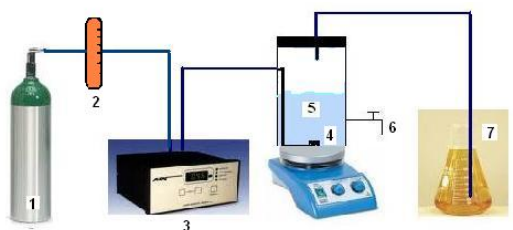
Figure 1. Schematic diagram of catalytic oxidation system. (1) Pure oxygen, (2) Flow meter, (3) Ozone generator, (4) Magnetic stirrer, (5) Ozonation reactor, (6) Water sample point, (7) KI